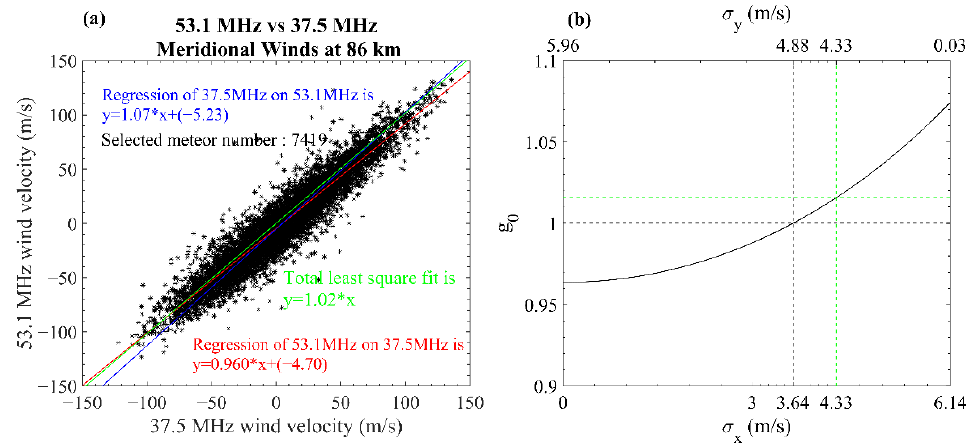
Figure 3. Quantitative example of the relationship among parameters. ( a ) Scatter plot of the hourly meridional winds (asterisks) at a height of 86 km measured by the two MRs and averaged over 14 months. The red line represents the regression of the 53.1 MHz MR winds on the 37.5 MHz MR winds, and the blue line indicates the opposite. The green line indicates the total least squares regression fit of all available data. The number of the selected meteors and the slopes of these three lines are also labeled. ( b ) The mathematical relationship between g 0 , σ x , and σ y . The black curve represents the numerical relationship; the green dashed lines represent the values of g 0 , σ x , and σ y under the assumption that σ x and σ y are equal; and the black dashed lines represent the values of random noise when g 0 =